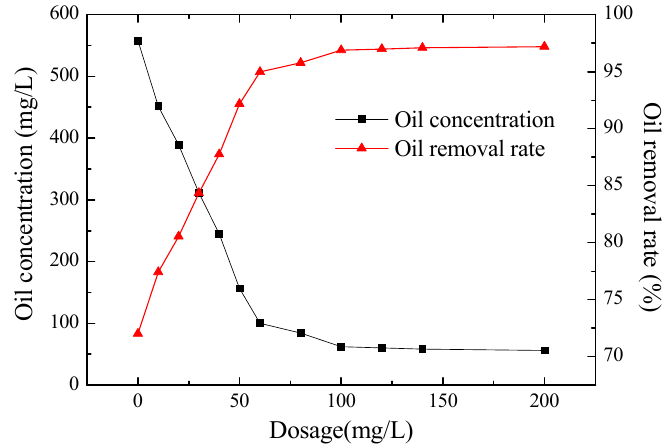
Figure 2. E ff ect of the dosage on oil concentration and oil removal rate. Figure 2. Effect of the dosage on oil concentration and oil removal rate. Figure 2. Effect of the dosage on oil concentration and oil removal rate.